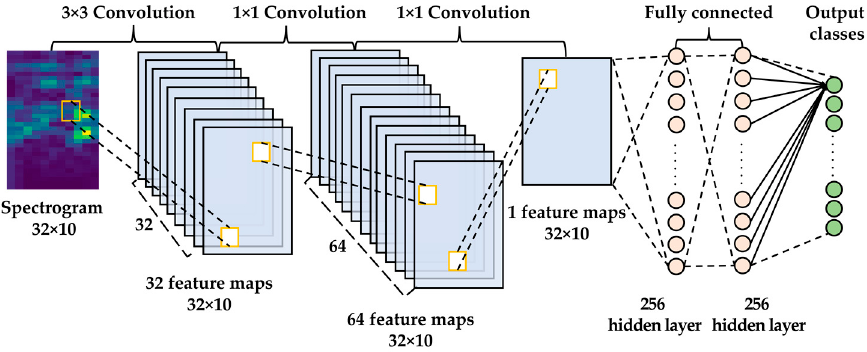
Figure 2. Architecture of the proposed lite CNN model for bearing fault diagnosis.